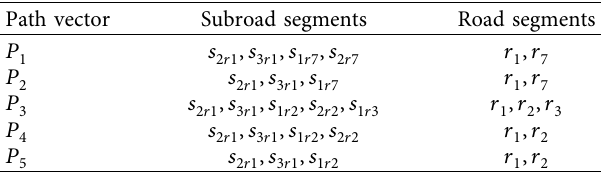
Table 2: Example diagram of path vector. Path